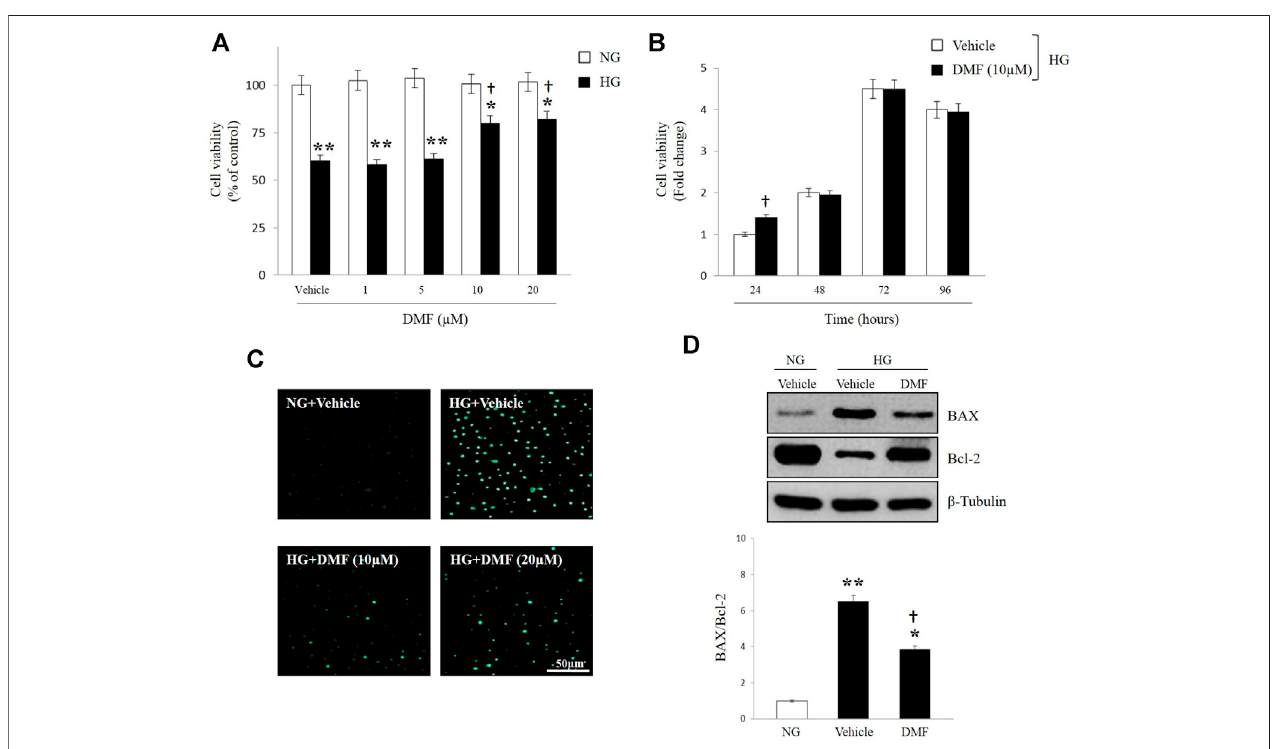
FIGURE 1 | Effects of DMF on RPE cells viability. ARPE-19 cells exposed to normal glucose (NG) or high glucose (HG) w/or w/o DMF. Cell viability (A,B) , DNA damage (C) BAX and Bcl-2 protein expression (D) were assessed. (A,B) MTT analyses: values are expressed as percentage of cell viability of NG treated-vehicle group (Vehicle/NG) or Fold change ± SEM. ( n (cid:2) 6; * p < 0.05 or ** p < 0.01 vs. Vehicle/NG; † p < 0.05 vs. Vehicle/HG. (C) Apoptotic assay by nuclear staining: Representative photomicrographsofARPEcellsexposedtoNGandHGandtreatedwith10or20 μ MDMFupto24 h.Cellswerestainedwiththe fl uorescentnucleardyeHoechst 33,258andobservedat × 40magni fi cation.Scalebar (cid:2) 50 μ m.( D )WesternblotanalysesofBAXandBcl-2inARPEcellsexposedtoHGw/orw/oDMF(10 μ M)for24 h. Band densities were quanti fi ed by ImageQuantTL software and normalized values were indicated below each corresponding band. Normalized band density values in control groups (NG) were set to 1. * p < 0.05 or ** p < 0.01 vs. NG; † p < 0.01 vs. Vehicle/HG; n (cid:2)